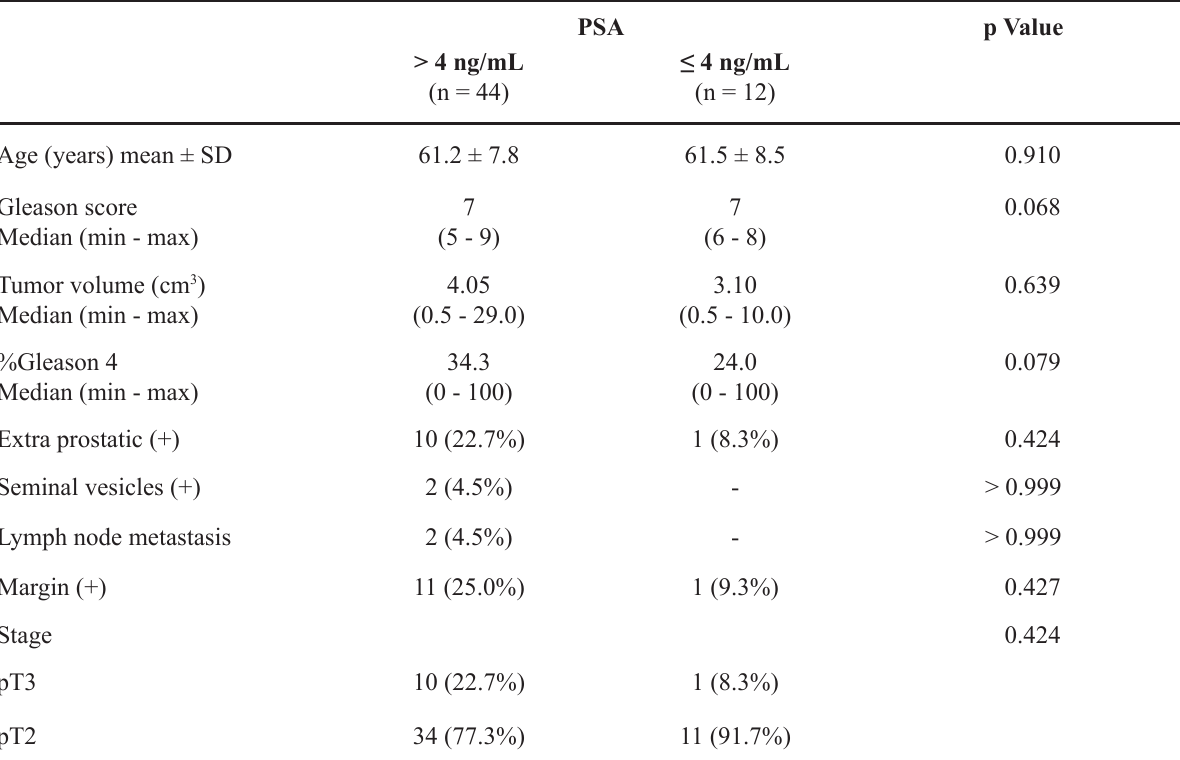
Table 4 – Patient age and tumor characteristics in radical prostatectomy specimens when PSA was ≤ 4 ng/mL or > 4